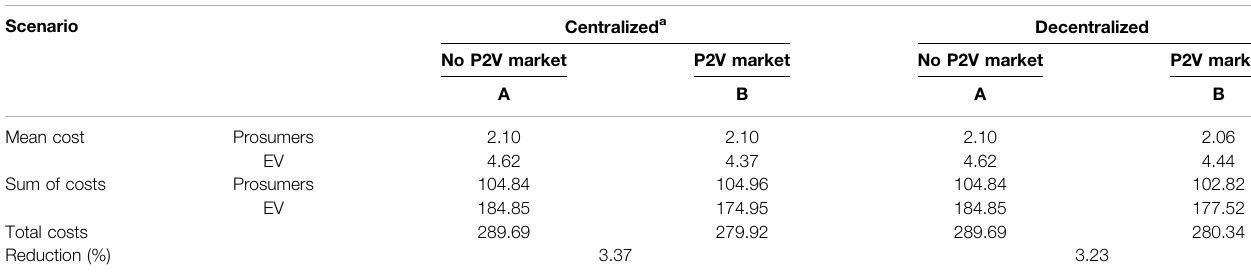
TABLE 4 | Optimization results ( €